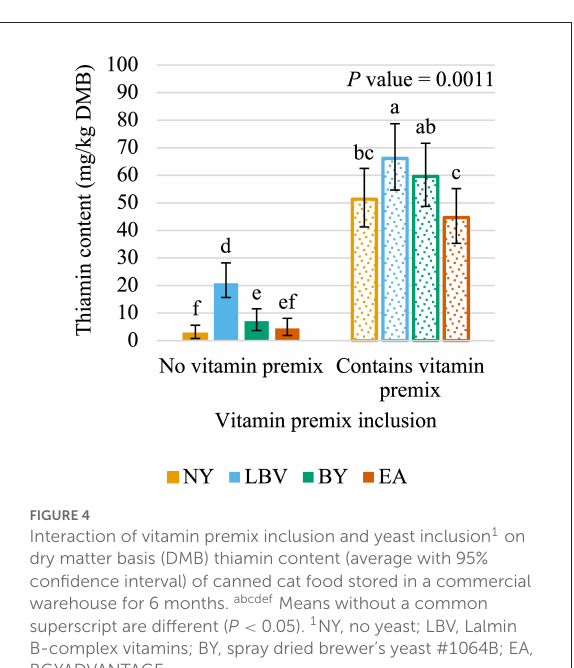
FIGURE4 Interaction of vitamin premix inclusion and yeast inclusion 1 on dry matter basis (DMB) thiamin content (average with 95% confidence interval) of canned cat food stored in a commercial warehouse for 6 months. abcdef Means without a common